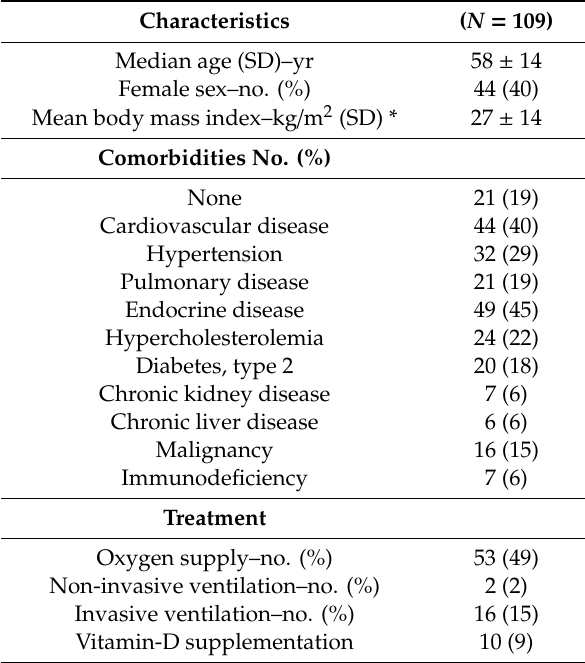
Table 1. Demographics and clinical characteristics of patients with